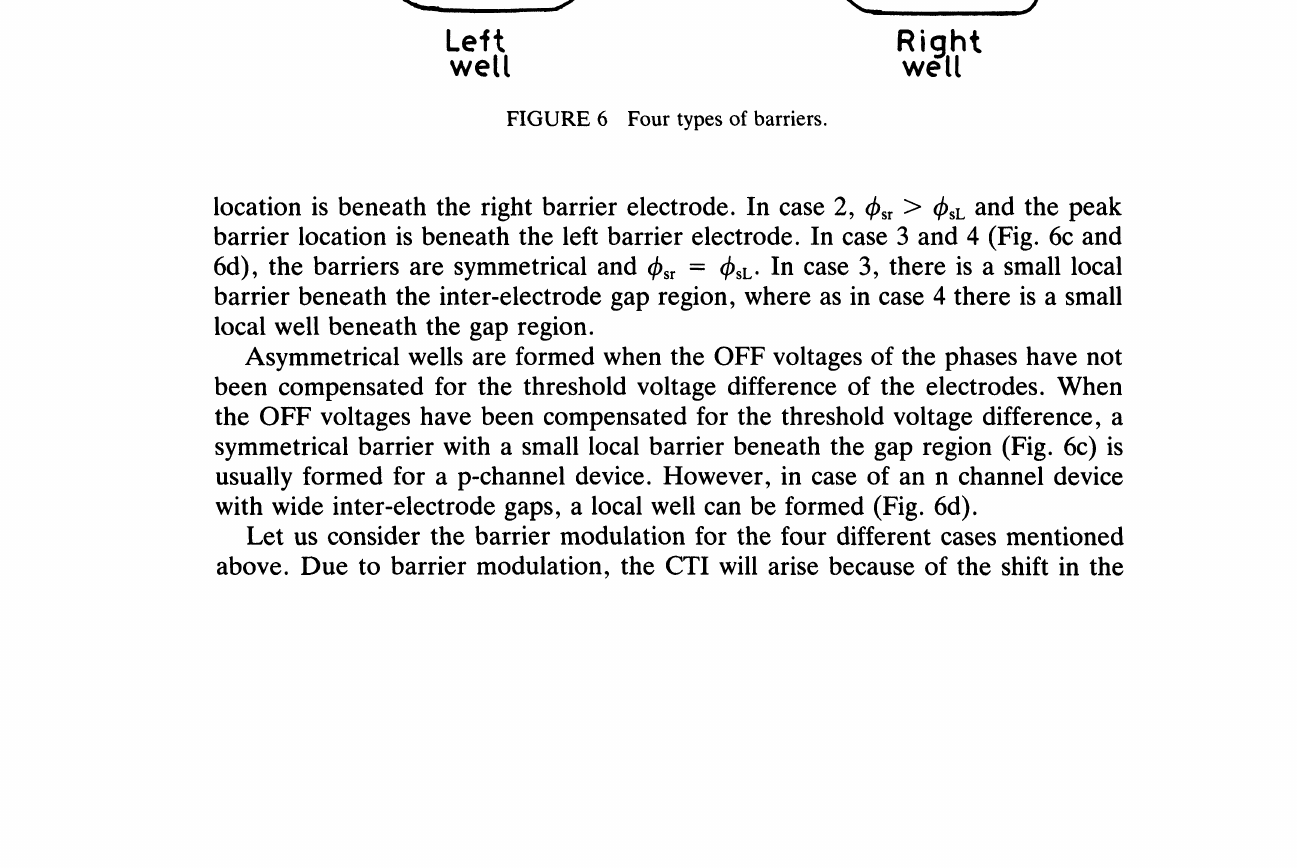
FIGURE 6 Four types of